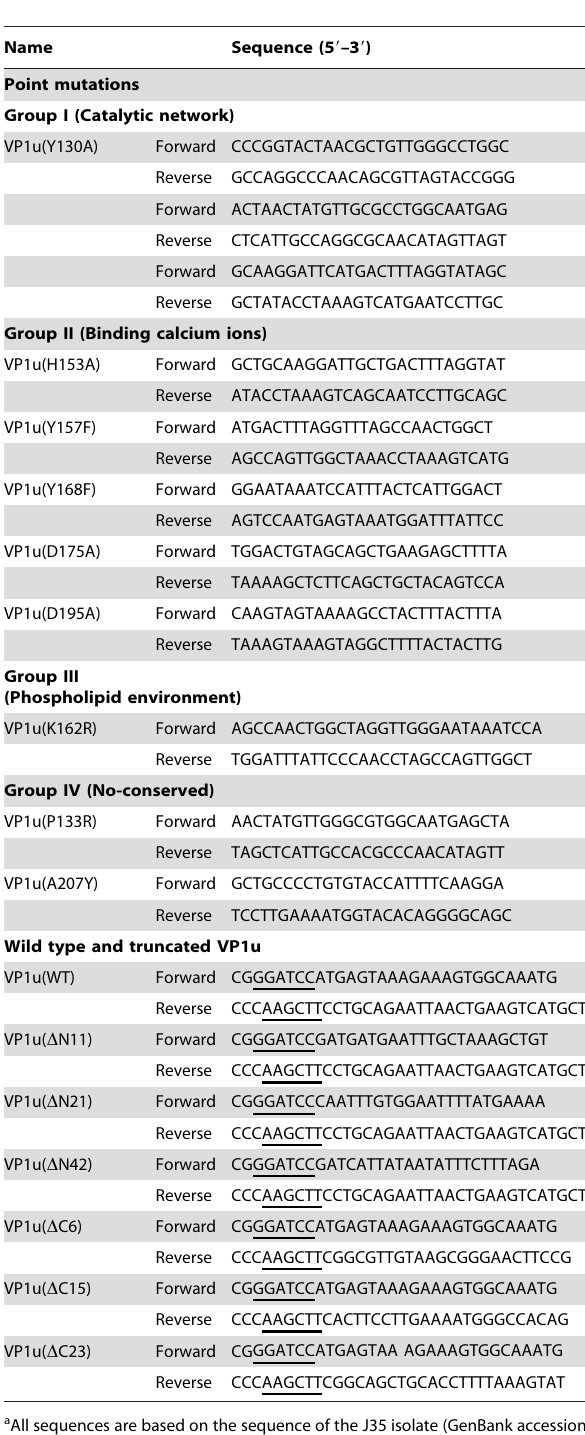
Table 2. Primers used to construct B19 VP1u point mutations and truncated